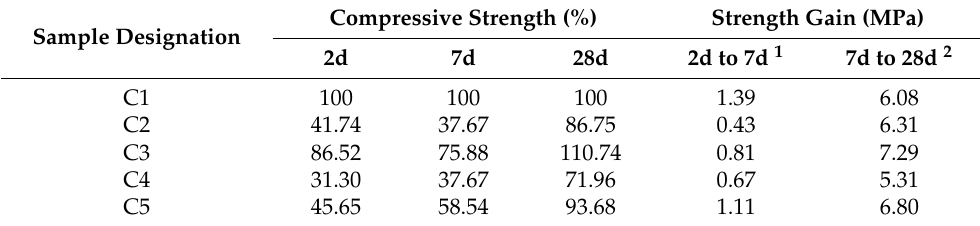
Table 9. Additional information obtained on the basis of a compressive strength test.